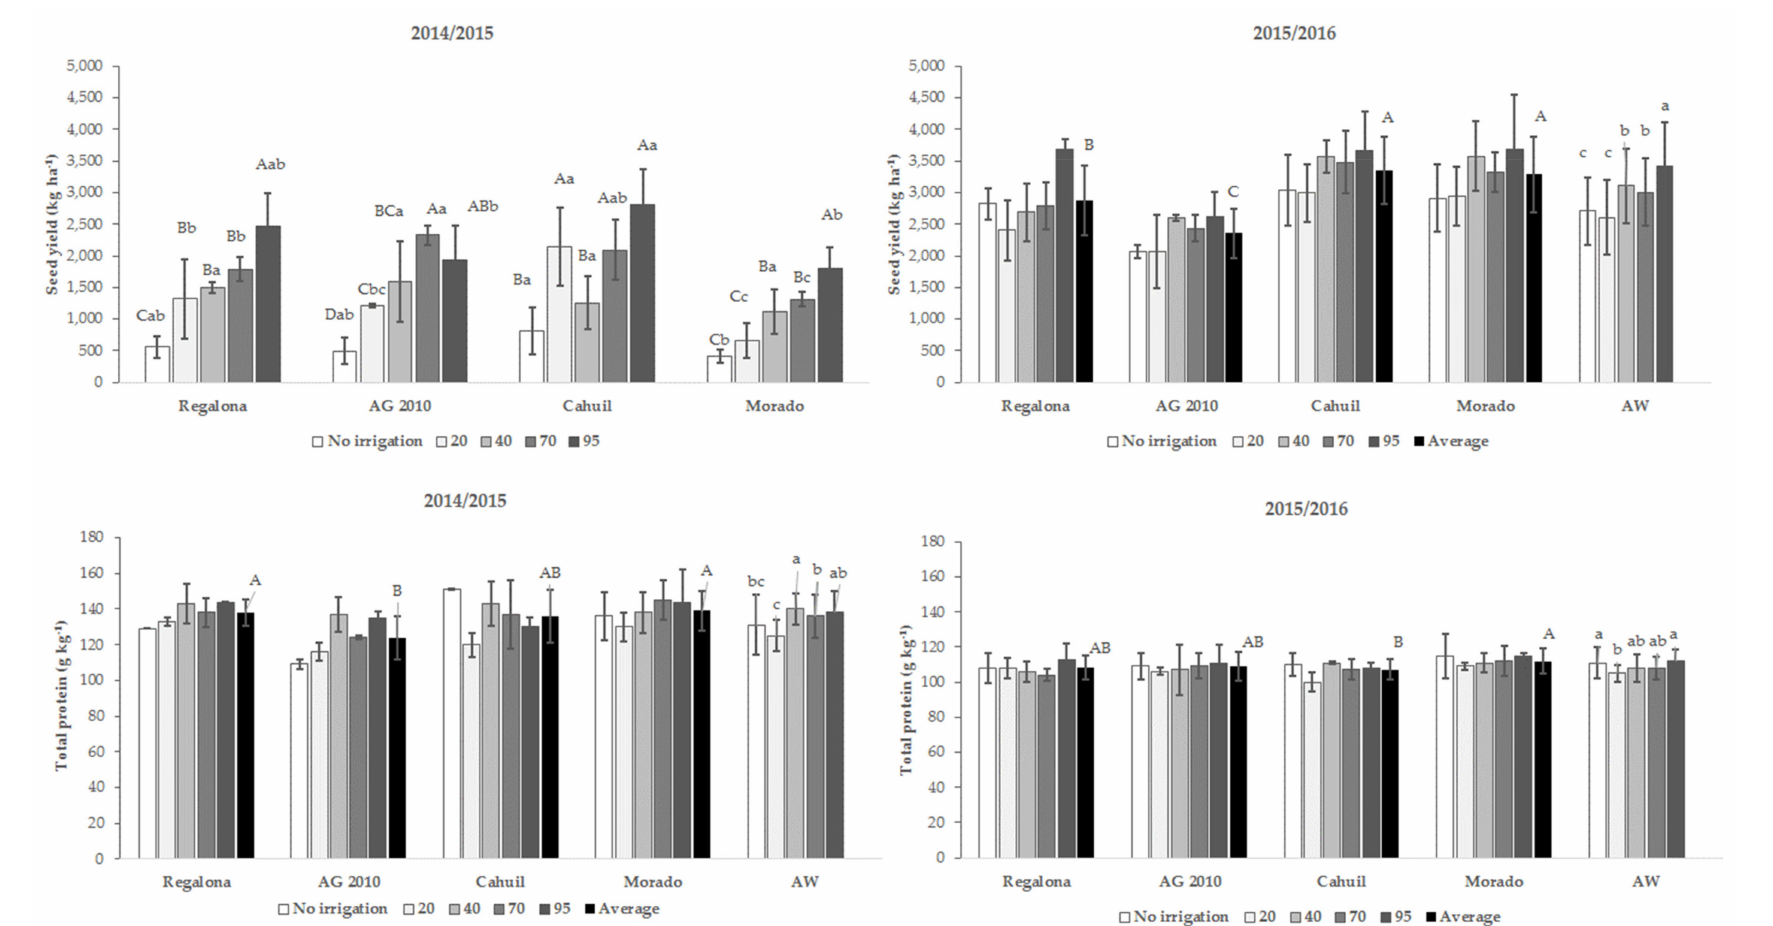
Figure 2. Seed yield and total protein content in four quinoa genotypes subjected to different water deficit conditions. Different lowercase letters indicate significant difference between water deficit conditions ( p ≤ 0.05). Different capital letters are significant difference between genotype ( p ≤